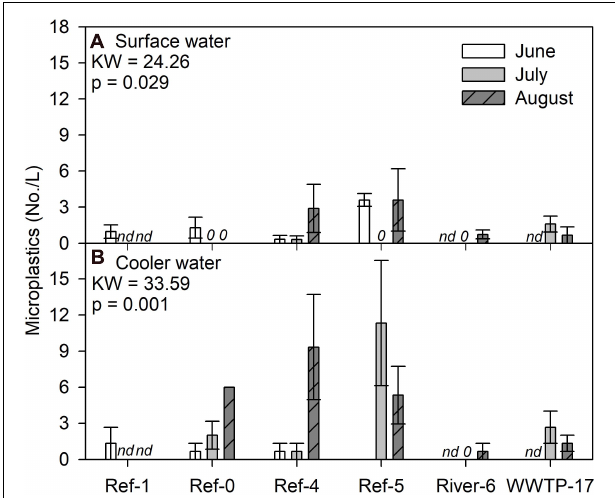
FIGURE 5 | Mean ( ± SE) microplastic particle concentrations in (A) surface and (B) cooler water from Milwaukee Harbor in summer 2018. K–W test results are shown in each panel, and degrees of freedom = 13. Sites 0–5 are reference (Ref) locations, River-6 is at river confluence, and WWTP-17 is the wastewater treatment plant (WWTP) outfall. nd, no data.